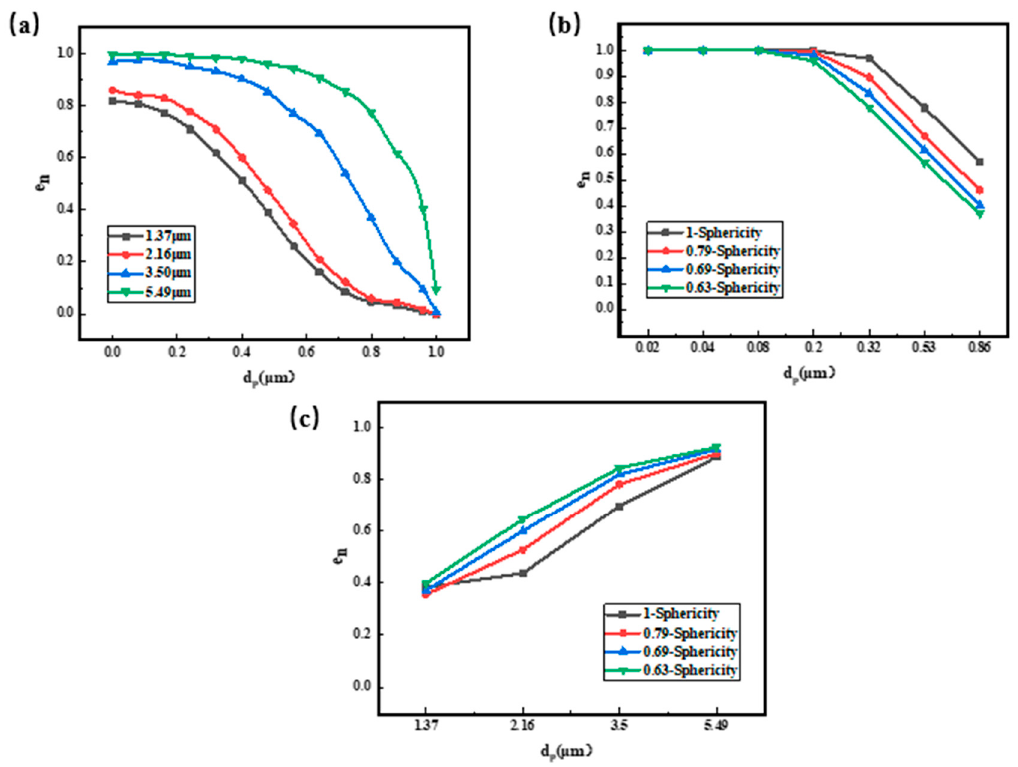
Figure 7. Trapping efficiency for different particle sizes (The sphericity is ( a ) 1 ( b ) 0.79 ( c ) 0.63).